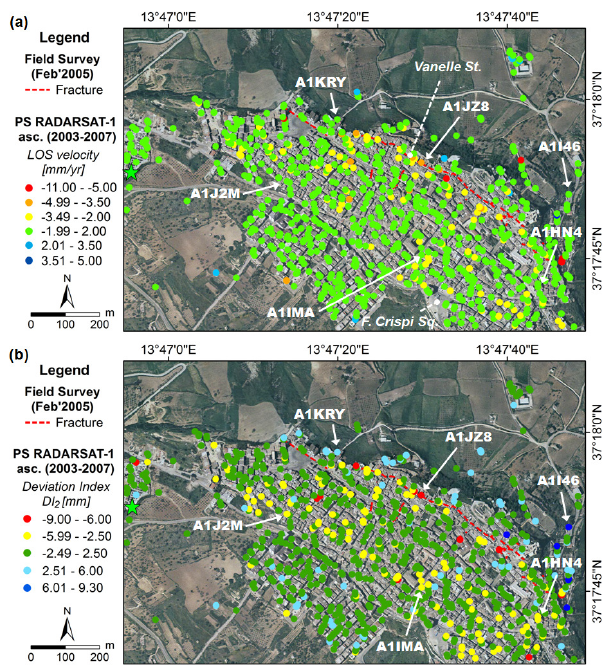
Fig. 7. Naro test site: LOS velocity (a) and Deviation Index DI 2 (b) . The reference point is represented as a green Figure 7. Naro test site: LOS velocity (a) and Deviation Index DI 2 (b). The reference point is 639 represented as a green star. 640